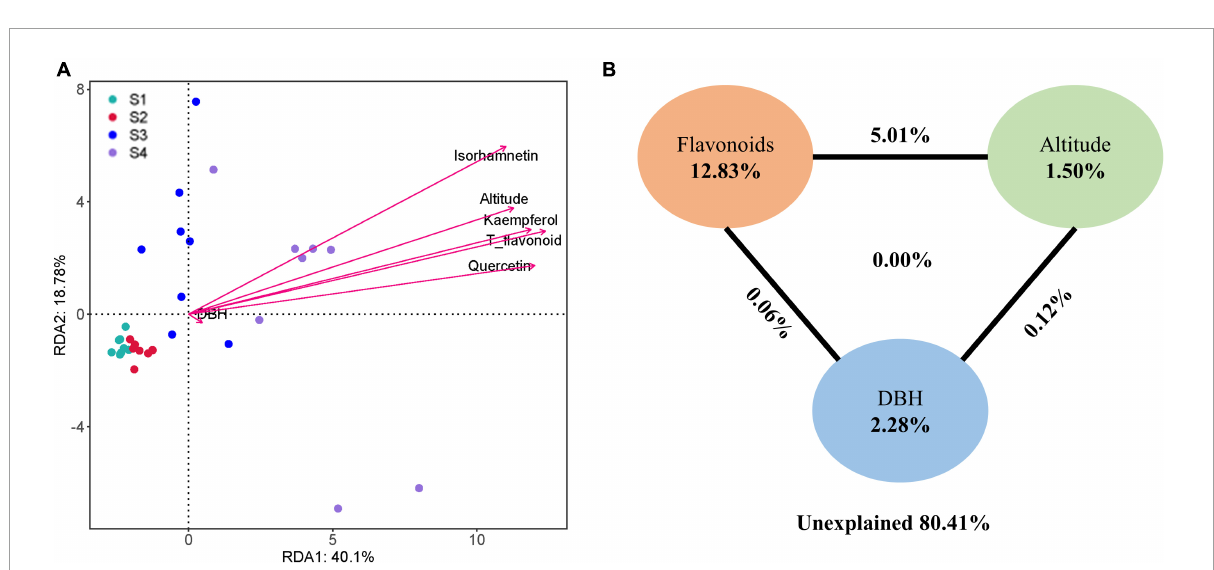
FIGURE4 (A) Redundancy analysis (RDA) and (B) variance partitioning analysis (VPA) of the relationships between endophytic bacterial community and environmental variables in Ginkgo biloba leaves.